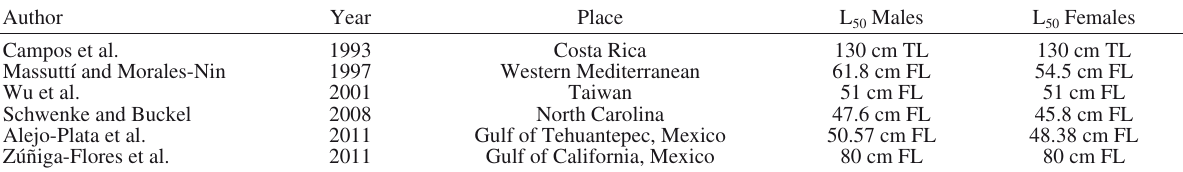
Table 6. – Size at first sexual maturity (L ) for males and females of dolphinfish, Coryphaena hippurus , reported in the 50